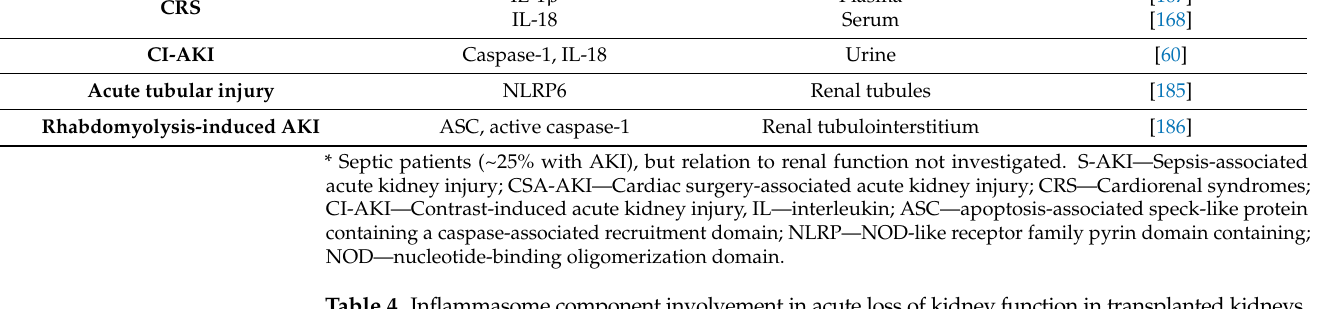
Table 4. Inflammasome component involvement in acute loss of kidney function in transplanted